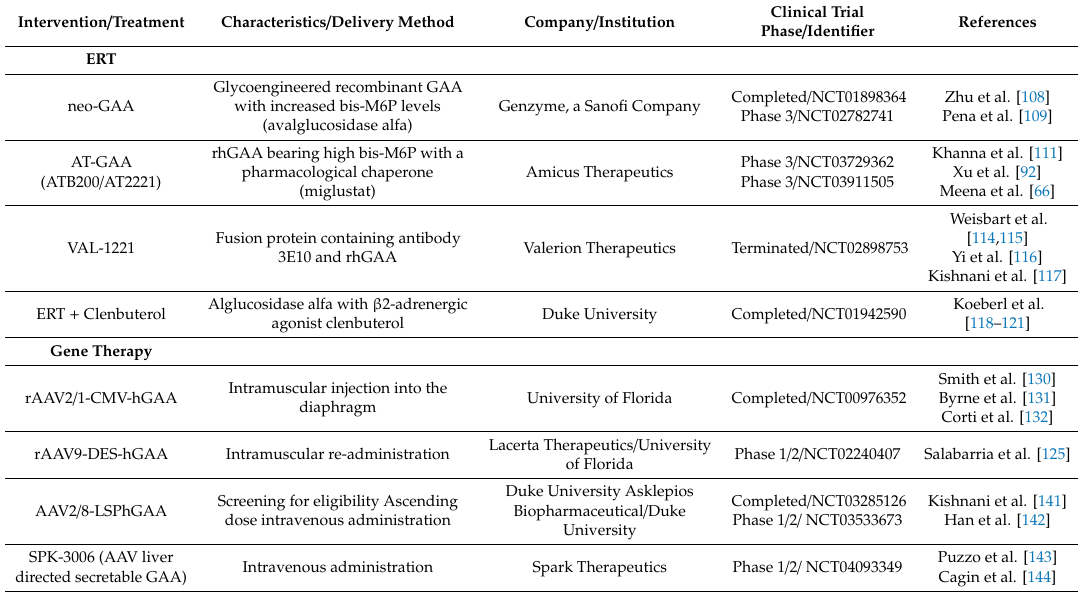
Table 1. Next generation therapies for Pompe